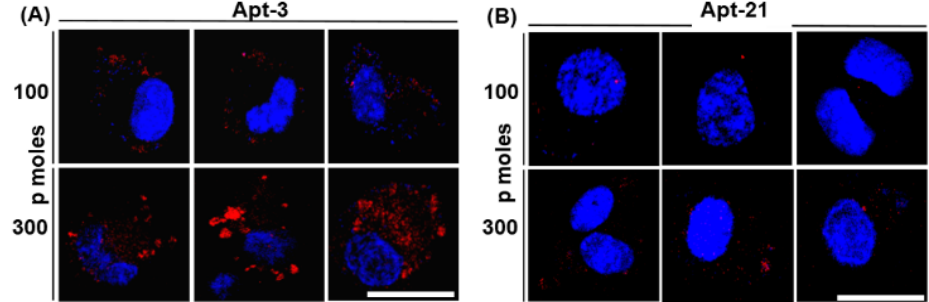
Figure 4. Aptamer 21 per se does not bind to THP-1 macrophages. In 2-well chamber slides, Cy5- labelled apt-3 ( A ) and -21 ( B ) were incubated at 100 ( top panels ) and 300 picomoles ( lower panels ) for 4 h with 10 5 PMA-differentiated THP-1 macrophages at 37 °C and 5% CO 2 . The unbound ap- tamers were washed off with pre-warmed 1× PBS (pH 7.4). Cells were fixed with BD cytofix/cyto- permeabilization kit and mounted with Prolong Gold antifade DAPI to observe under the confocal microscope. Blue, DAPI (nuclear staining of THP-1); Red, apt-3/-21. The images were captured at 60× magnification. White bars in ( A , B ) bottom right-most panels indicate scale bar of 20 µm (applies to all 12 panels).